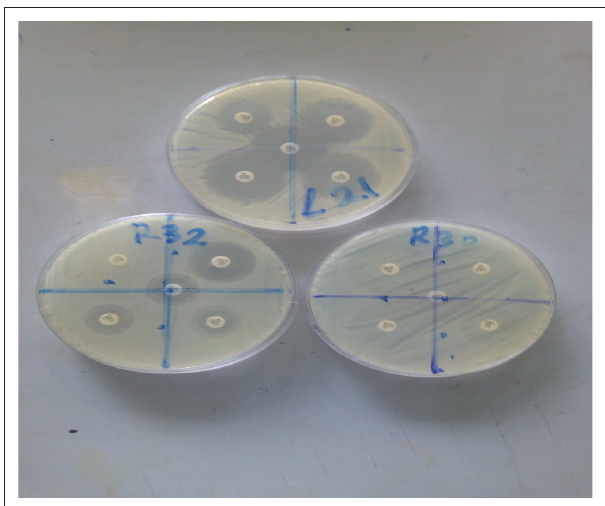
FIGURE 2: Cultured agar plates of isolates with zones of bacterial inhibition (L21, R32) and Escherichia coli resistance to antibiotic discs